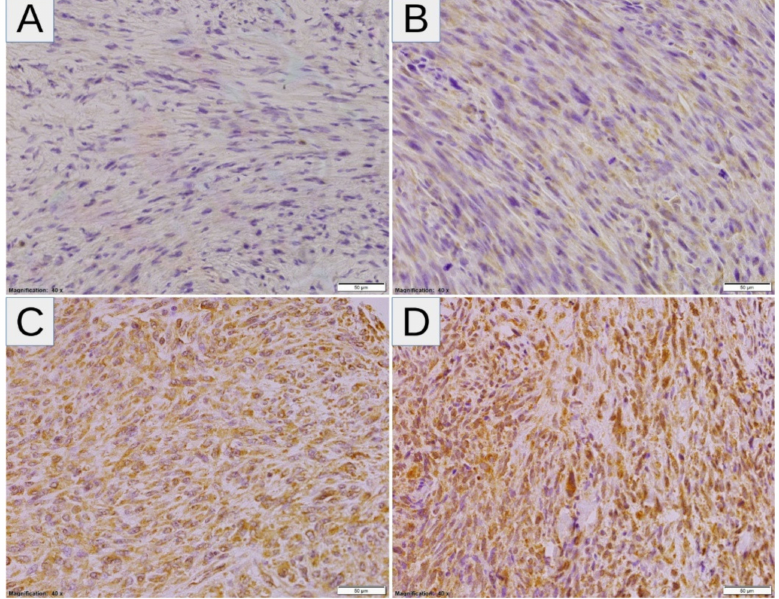
Figure 4. ( A – D ) Representative VEGFA staining patterns in MPNST: ( A , B ) Cases with absent-to- very-low ( A ) and low-to-intermediate (1+/2+) ( B ) cytoplasmic expression of VEGFA (the expression coefficient—1, low-expression and 7, low-expression, respectively). ( C , D ) Cases with predominantly intermediate/high- (2+/3+) ( C ) and high-intensity (3+) ( D ) cytoplasmic expression of VEGFA (the expression coefficient—11, high-expression, and 12, high-expression, respectively). Abbreviations: